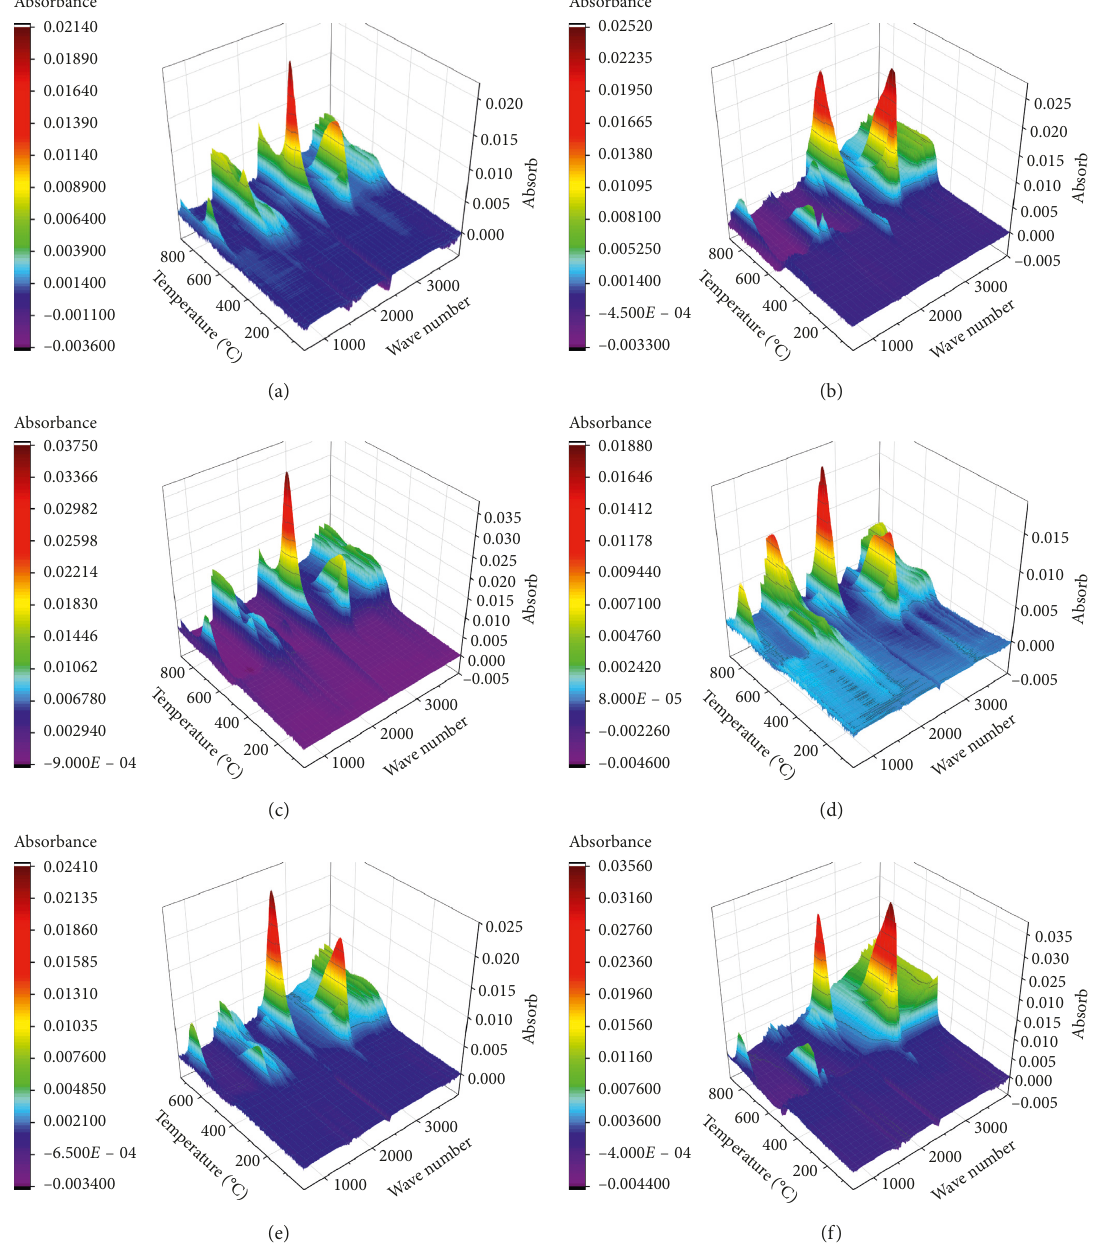
Figure 4: Time-domain analysis of FTIR spectroscopy